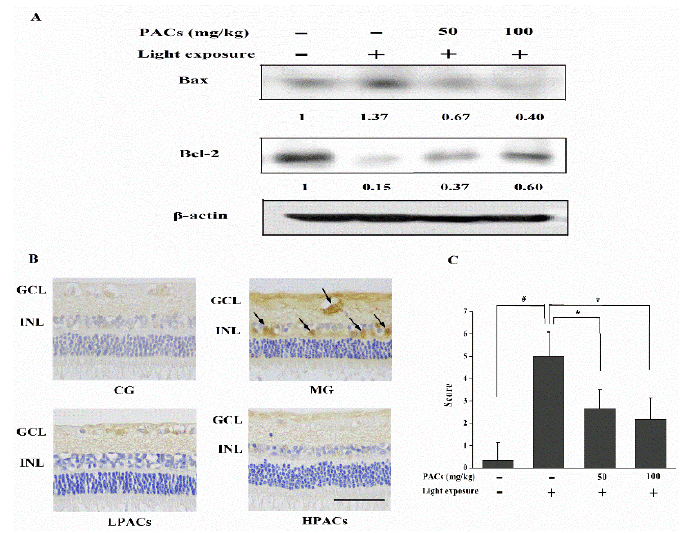
Figure 5. ( A ) Effect of sea buckthorn seed PACs on Bax and Bcl-2 expression in retinas based on Western blot analysis at 7 day after light exposure (18,000 lx). The numbers underneath the blots represent band intensity (normalized to β-Actin loading control, means of three independent experiments) measured by ImageJ software. The standard deviations (all within ±15% of the means) were not indicated. ( B ) Active caspase-3 expression in retinas 7 d after light exposure. Active caspase-3 cells were present, with brown-stained nuclei. GCL: ganglion cell layer, INL: inner nuclear layer. Scale bar: 50 μm. ( C ) Scores were determined by evaluating the extent and intensity of immunopositivity. Data are expressed as the mean ± standard deviation ( n = 6). (#, ∗ ) p < 0.05 (one‑way ANOVA followed by Tukey’s test) .